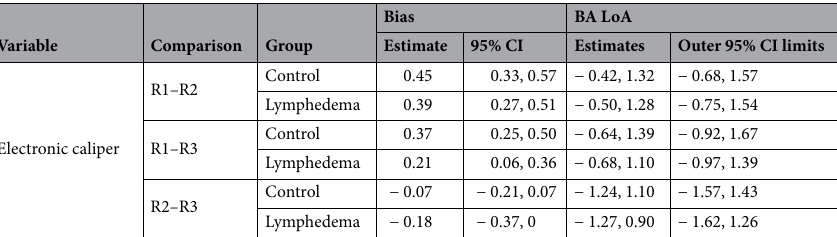
Table 3. Bias and BA LoA estimates with 95% CIs for interrater comparisons of electronic caliper. Data is presented as estimated mean difference and respective 95% confidence interval in millimeters (mm) supplemented by Bland–Altman Limits of Agreement. Bland–Altman Limits of Agreement is the mean difference ± 1.96 standard deviation of the difference. BA Bland–Altman, LoA Limits of Agreement, CI confidence interval, R1 rater 1, R2 rater 2, R3 rater 3.